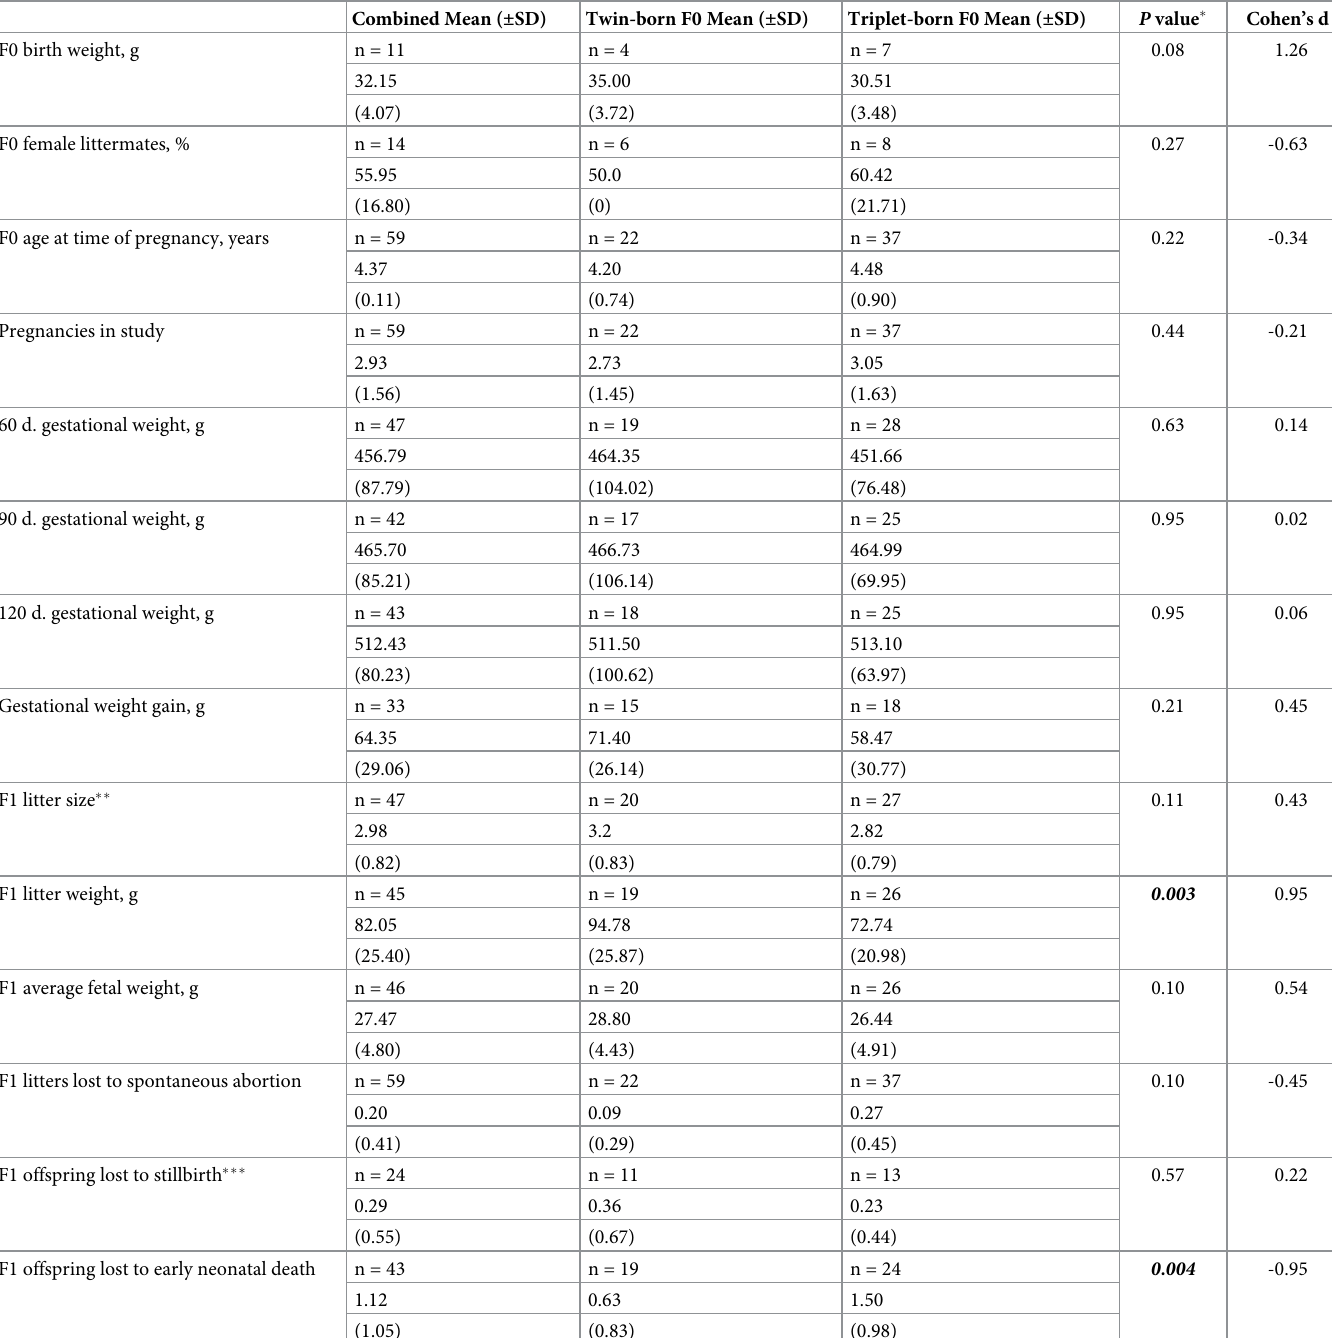
Table 1. Descriptive statistics and differences in pregnancy characteristics by maternal litter